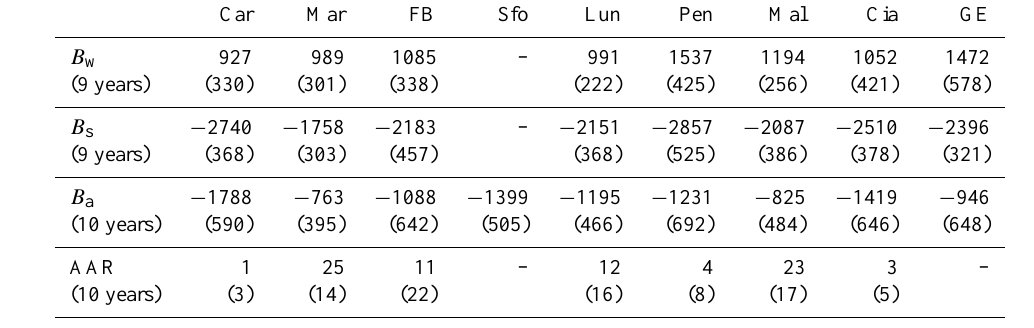
Table 2. Mean values (and standard deviation in brackets) of B w , B s , B a and AAR for nine Italian glaciers in the period from 2004 to 2013 (Car is Careser, FB is Fontana Bianca, Pen is Pendente, Cia is Ciardoney, Sfo is Sforzellina, GE is Grand Etrèt, Lun is Lunga, Mar is La Mare, Mal is Malavalle). Values are expressed in mmw.e. except for AAR, which is in percent.